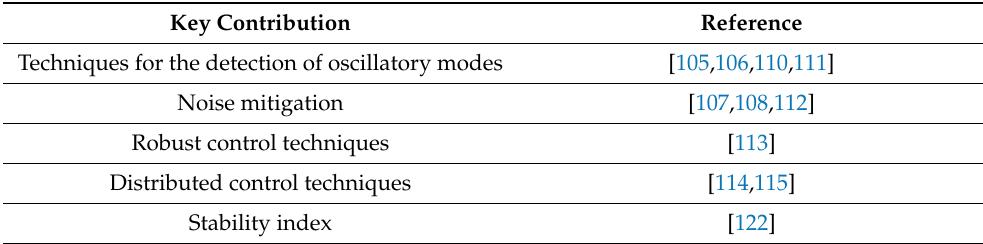
Table 8. Summary of contributions.